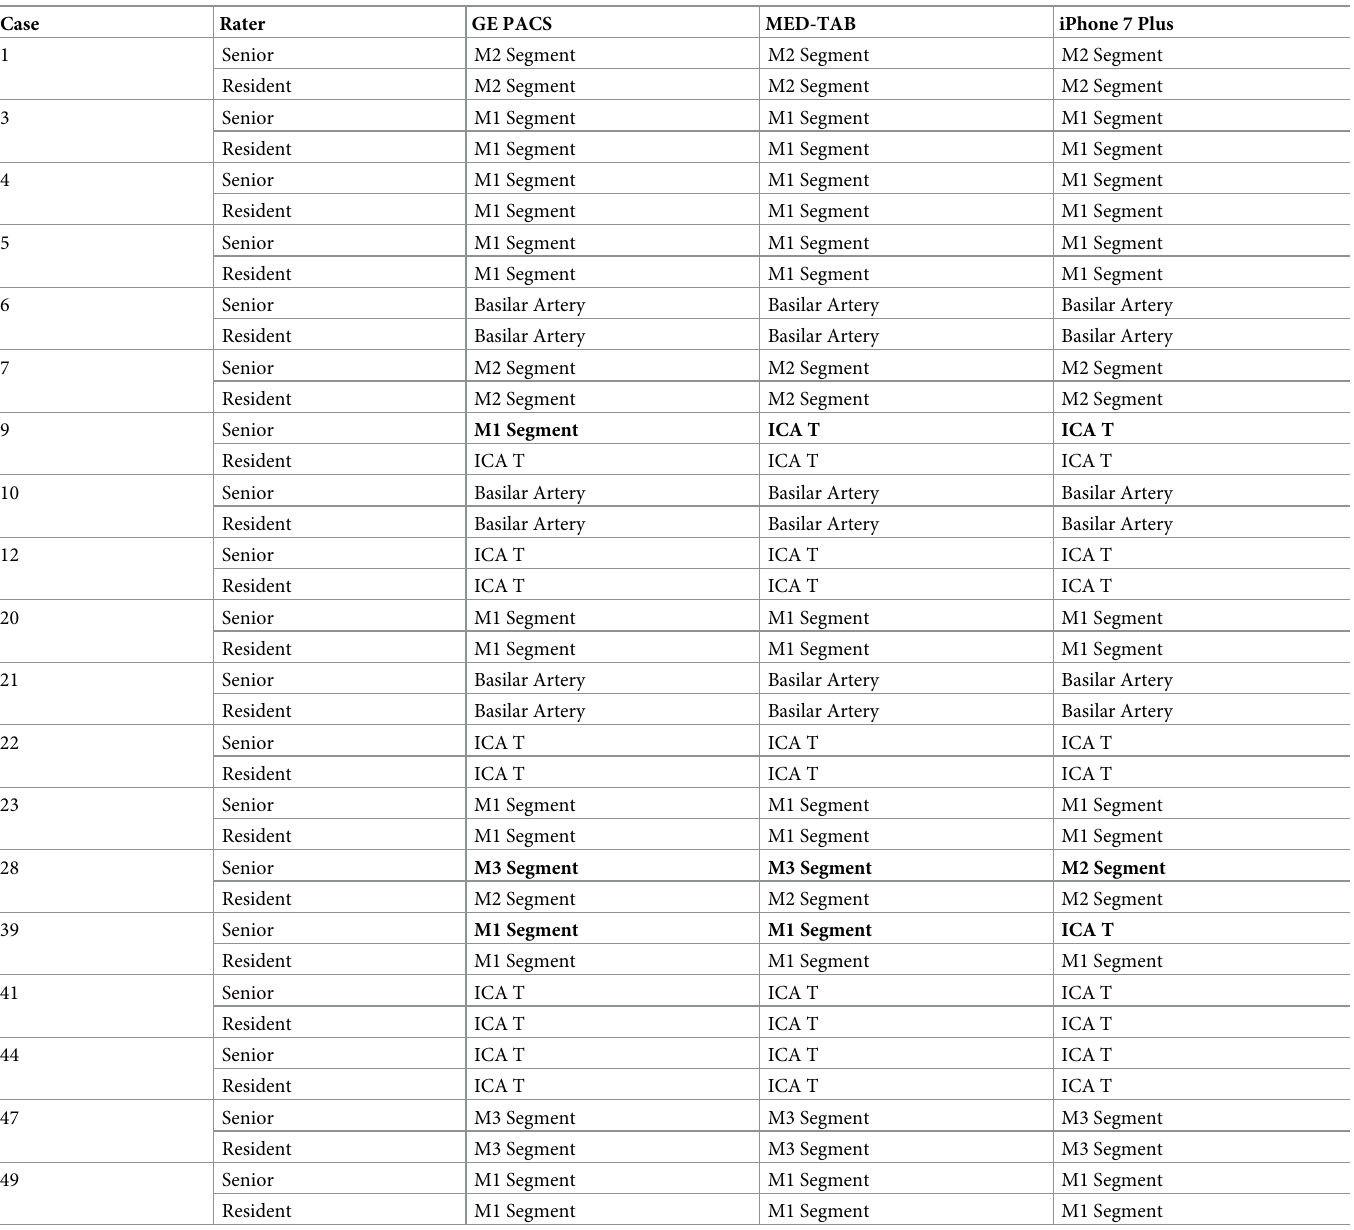
Table 2. Vessel location of the large-vessel occlusion for each